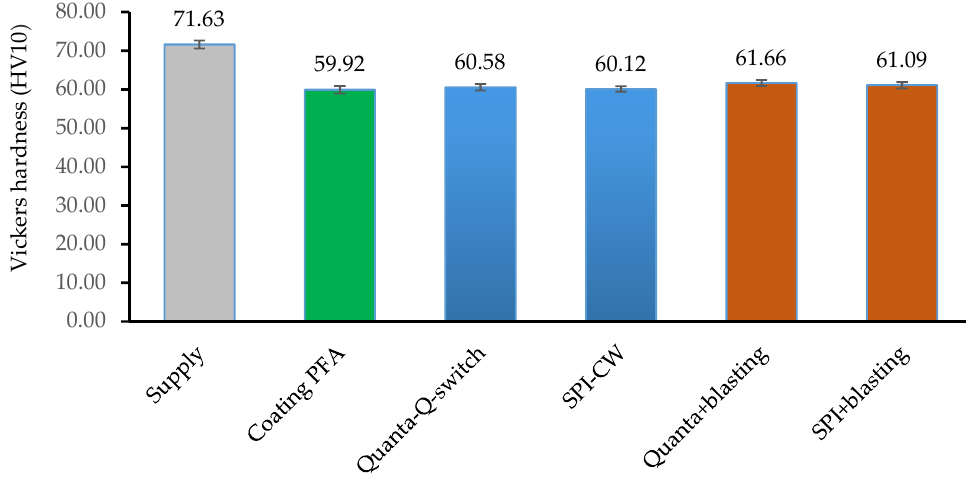
Figure 10. HV10 Vickers hardness on EN-AW5754 substrates in the different phases of supply, PFA coating, laser stripping, and final blasting.